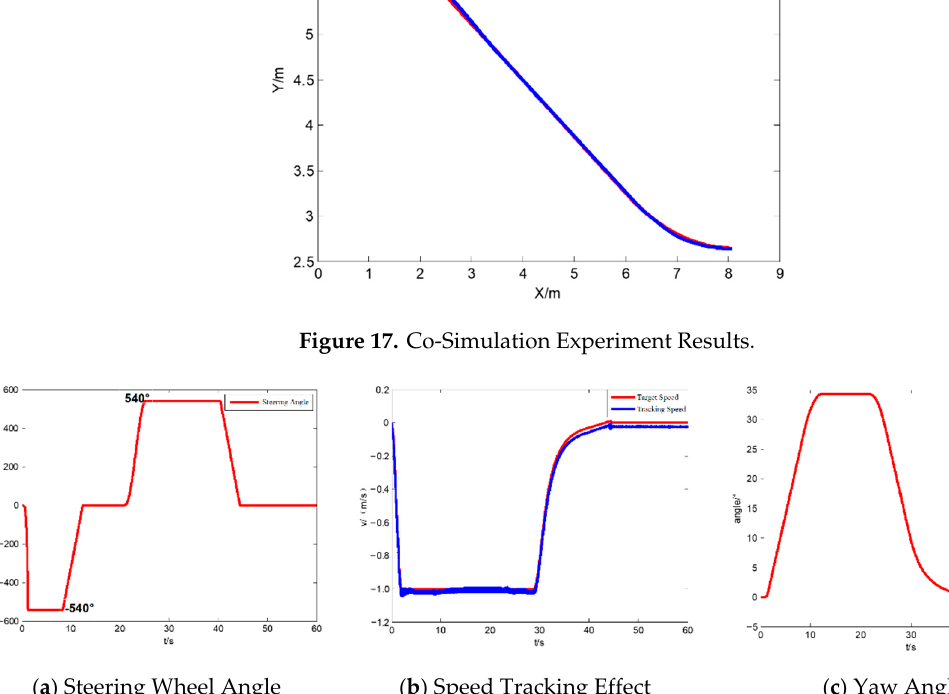
Figure 17. Co-Simulation Experiment Results.